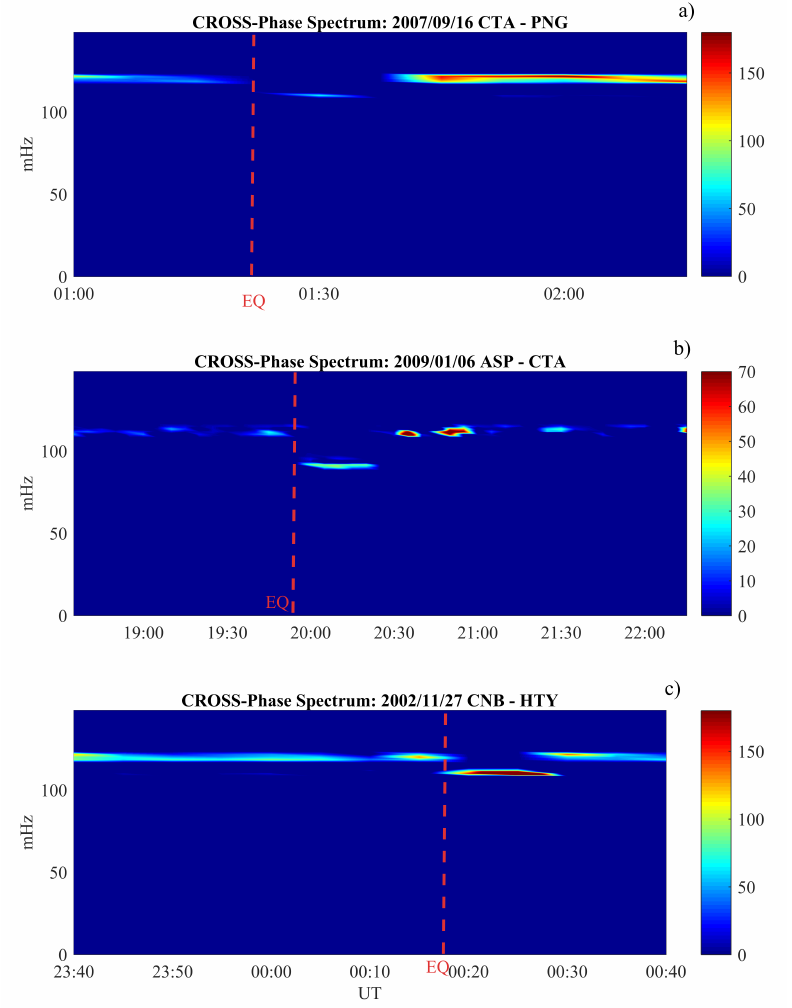
Figure 1. The cross-phase dynamical spectrograms between two low-latitude ground stations near the earthquake epicenter: panel ( a ) Sumatra 16 September 2009 EQ; panel ( b ) Indonesia 6 January 2009 EQ; panel ( c ) Philippines 11 November 2002 EQ. Each spectrum has been evaluated over a 1 h interval. Spectra have been smoothed both in time and frequency domains (7 frequency bands and 15 temporal bands). The red vertical line represents the earthquake occurrence time. In each panel the top caption reports the INTERMAGNET ground station codices used for the evaluation of the dynamical cross-phase spectrogram. The color-bar represents the phase difference in degrees between the equatorward and poleward ground